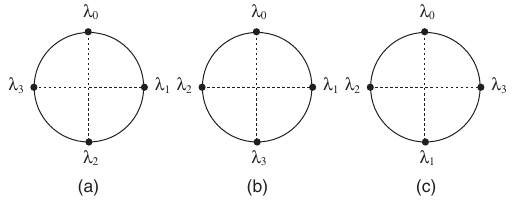
FIG. 5. (a) The weights j X r;c j 2 in Eq. (24) after diagonalization and in descending ordering. (b) The optimal permutation for D ¼ 4 . (c) The worst permutation for D ¼ 4 . The solid line represents the maximum weighting of multiplication in Eq. (24); the dashed lines represent minimum weights corresponding to 1